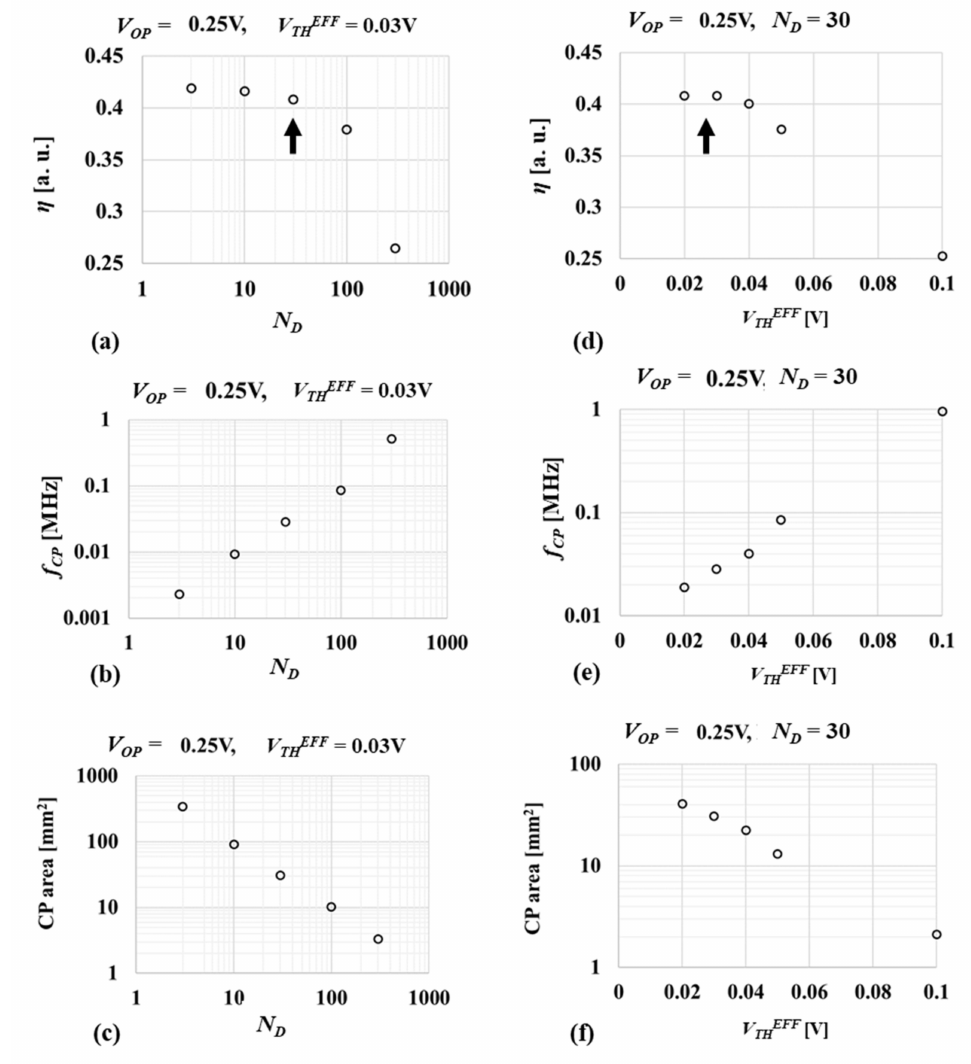
Figure 11. ( a ) η , ( b ) f CP , ( c ) CP area vs. N D and ( d ) η , ( e ) f CP , ( f ) CP area vs. V THEFF